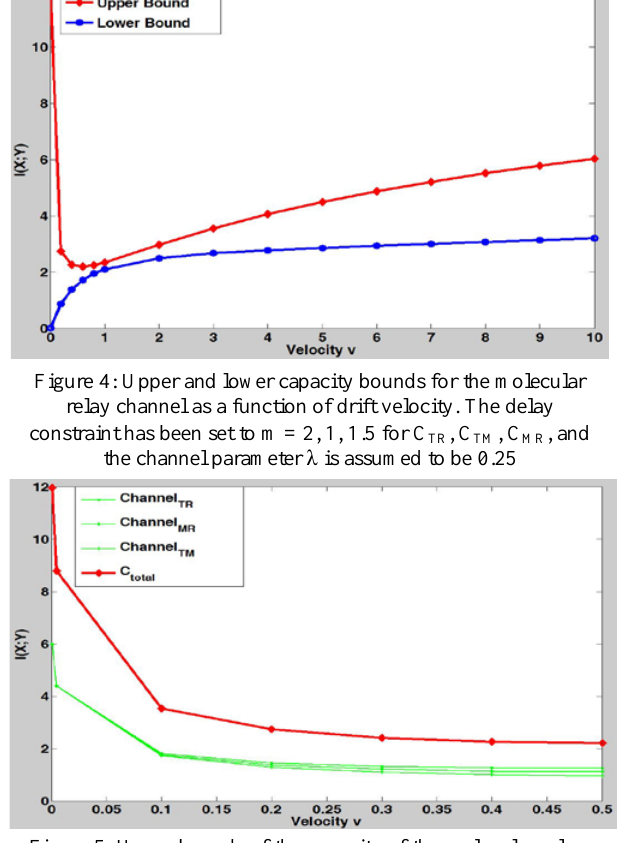
Figure 5: Upper bounds of the capacity of the molecular relay channel for smaller values of the drift velocity. The delay constraint has been set to m = 2, 1, 1.5 for C TR , C TM , C MR and the channel parameter λ is assumed to be